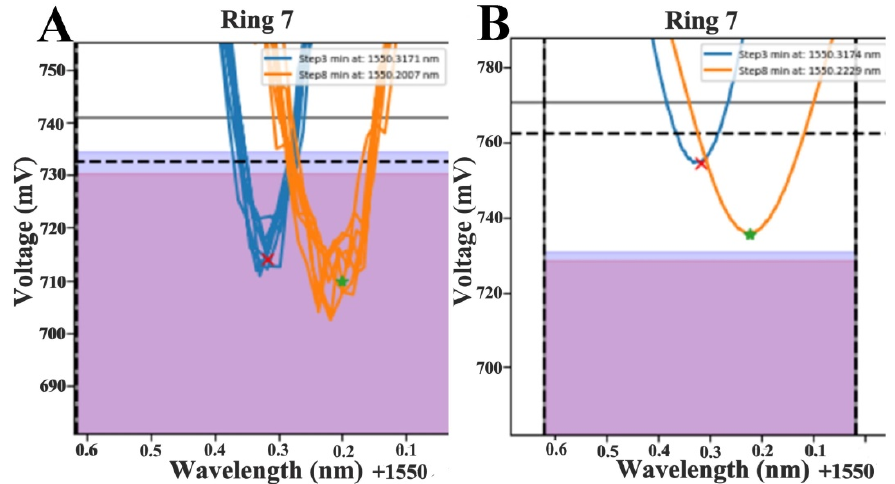
Figure 6. Application of the LOWESS algorithm to raw data: ( A ) data prior to algorithm implementation, ( B ) data after the implementation of LOWESS. The wavelength values (x-axis) used for shift estimation remained identical.